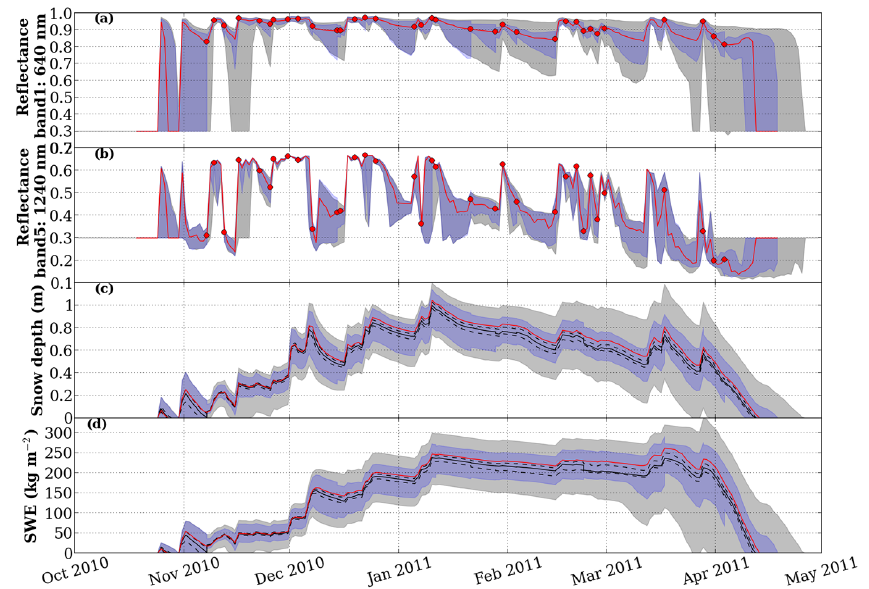
Figure 3. Evolution of the ensemble over the 2010/2011 season, (a) and (b) – reflectance at 640 and 1240nm (first and fifth MODIS band, respectively), (c) SD and (d) SWE. The blue shading represent the envelopes of the ensemble assimilating MODIS-like reflectances and the grey shading the envelopes of the ensemble without assimilation. The red lines represent the control simulation (synthetic truth). In graph (a) and (b) , the red dots show the assimilated observations. In both (c) and (d) , the black solid line shows the 50% quantiles (median of the ensemble) and the black dotted lines the 33 and 67% quantiles for the baseline